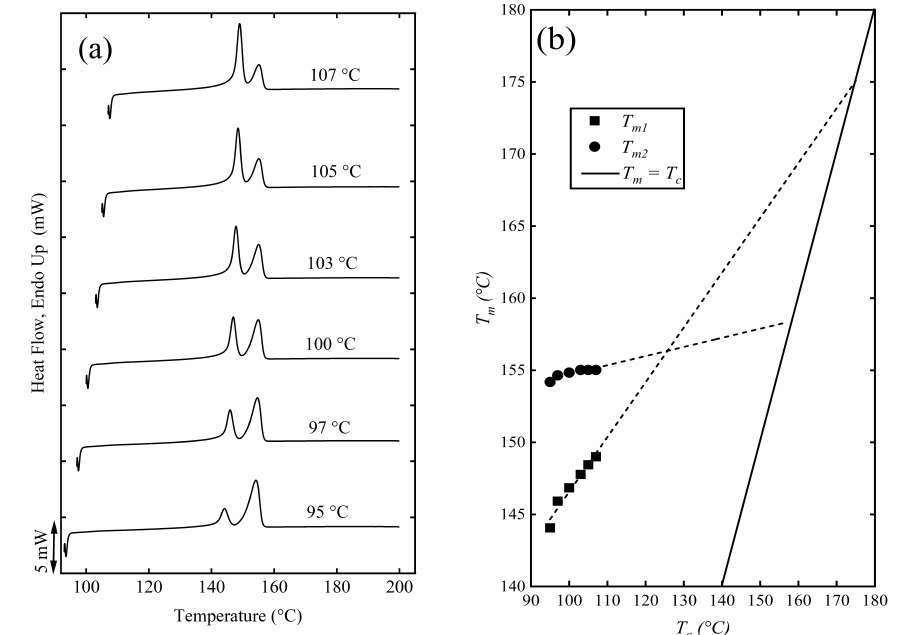
Figure 4. ( a ) DSC heating scans after isothermal crystallization at the indicated temperatures for the PLLA/SiO 2 (90/10) composite. ( b ) Hoffman–Weeks plot for the same composite.